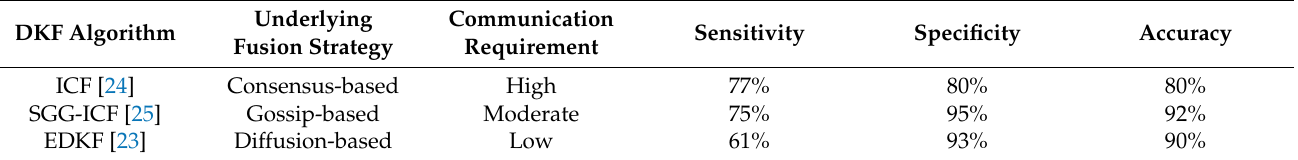
Table 5. Summary comparison of laboratory results of the selected DKF